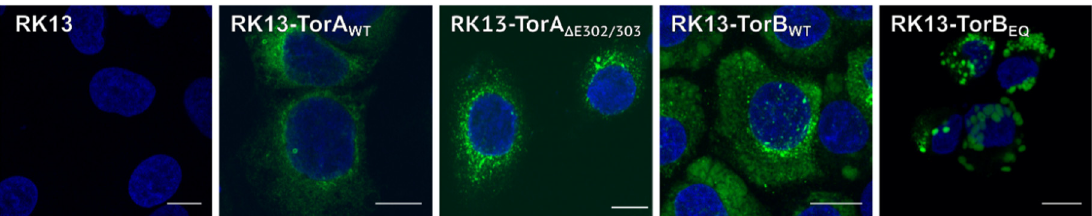
Figure 4. Localization of stably expressed RK13-GFP-TorA and -TorB. Representative merged images show the intracellular localization of RK13 cells stably expressing the GFP-tagged mutant and wild type proteins. Nuclei were stained with DAPI, and GFP autofluorescence was detected with a confocal laser scanning microscope. Scale bars indicate 10 µm.